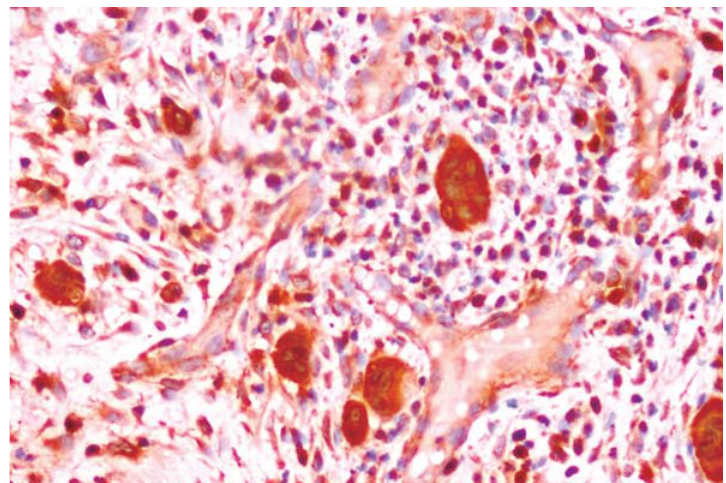
Figure 5- Oral squamous cell carcinoma (OSCC) showing type 4D diffuse widespread pattern of invasion (S100A4, 20x)